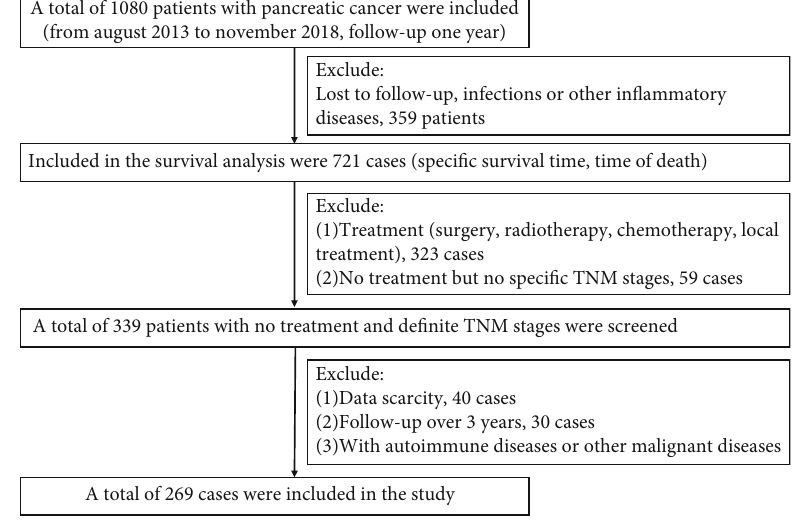
Figure 1: Research route.